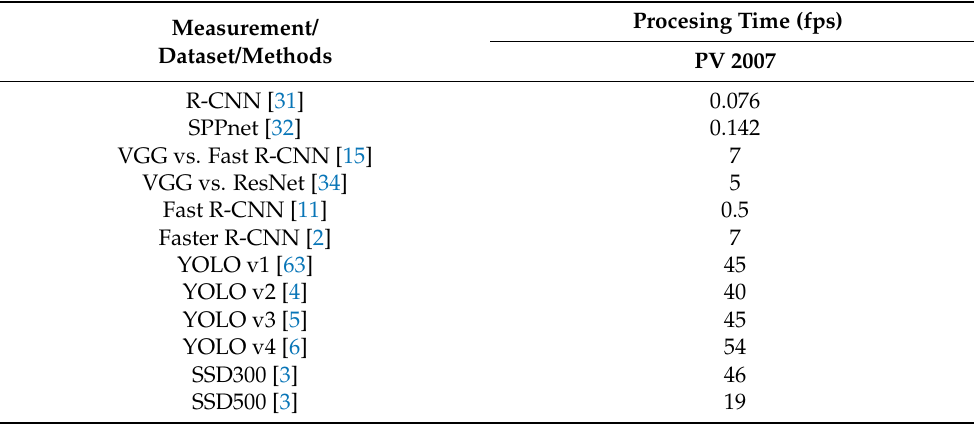
Table 2. The frame rate of human detection (fps—frames per second) on the PV 2007 benchmark dataset.